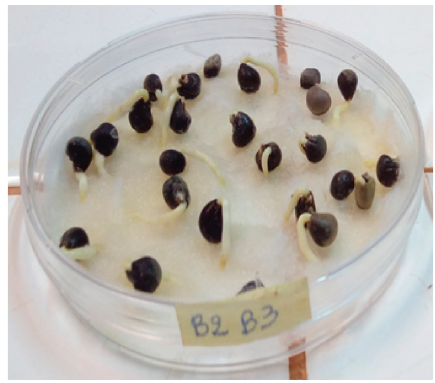
Figure 1: Germinated seeds of